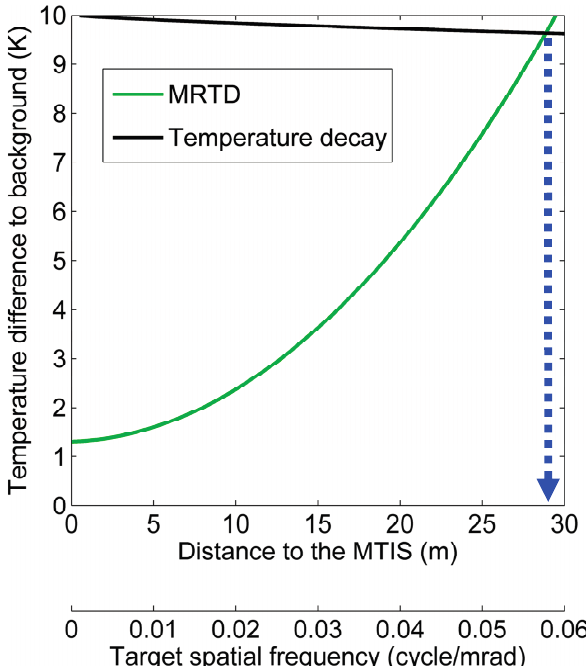
Figure 8. The intersection point of two curves indicates the estimation for the maximum working distance of MTIS. The black curve is derived by LOWTRAN (Low Resolution Atmospheric Radiance and Transmittance Model), which is a propagation model developed by U.S. Air Force Geophysics Laboratory (AFGL) for predicting atmospheric transmittance and background